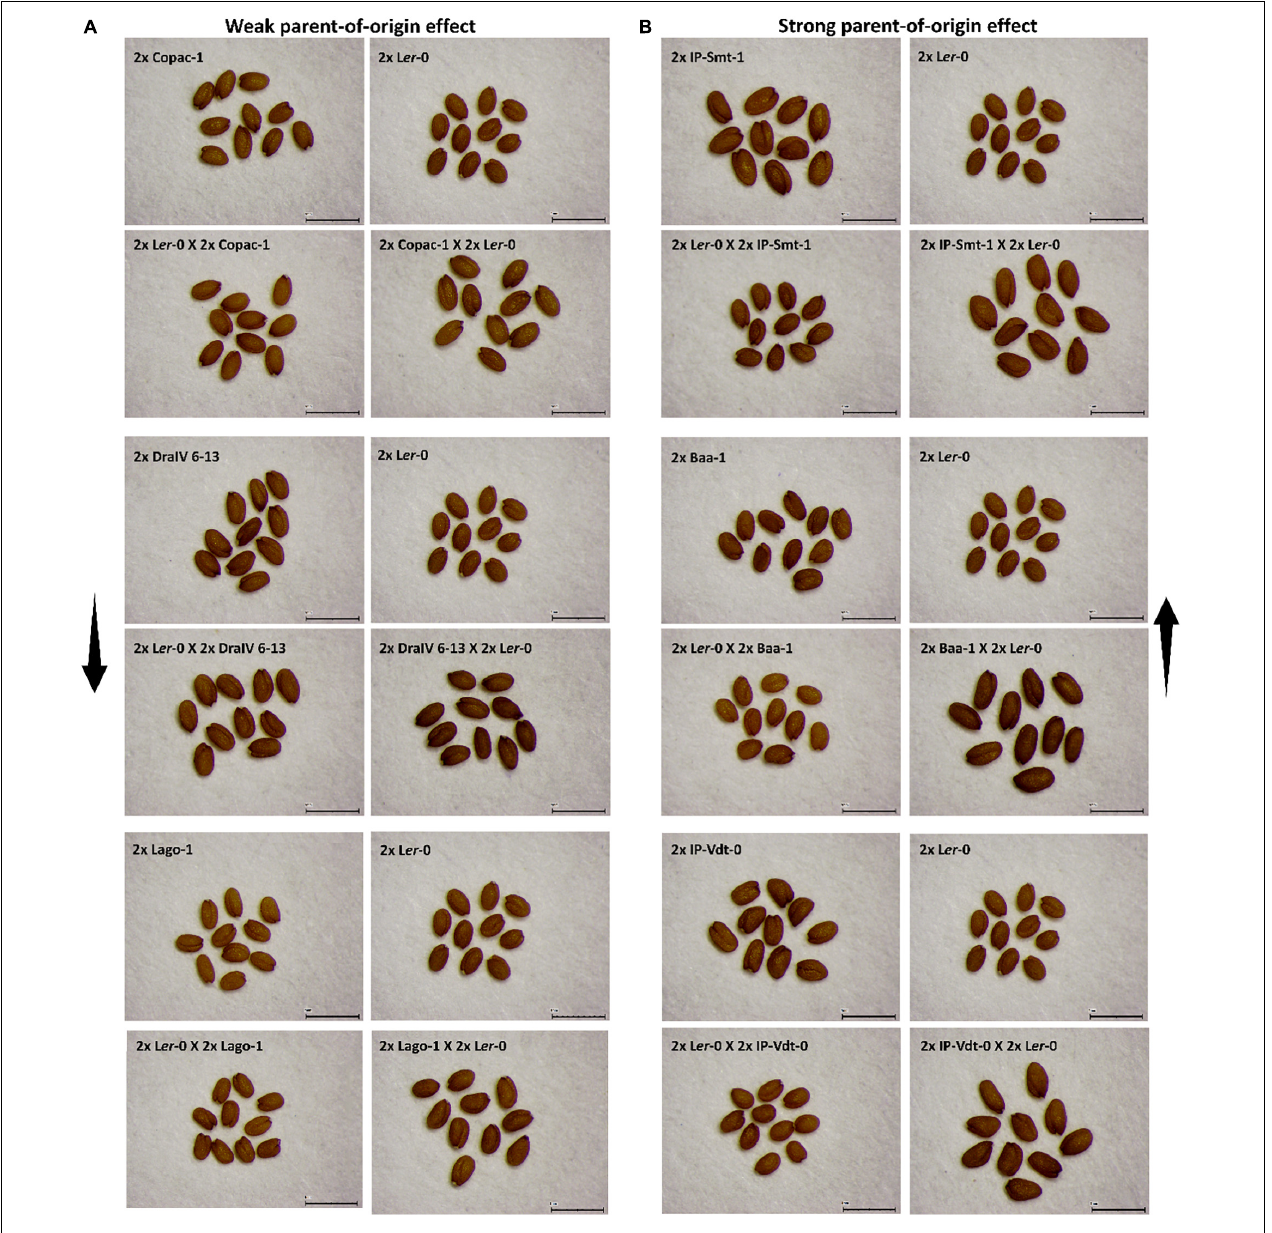
FIGURE 2 | Seed size phenotypes of reciprocal F1 hybrid diploid seeds and their parental lines. (A) The three F1 hybrid diploids with the weakest parent-of-origin effects on F1 seed size in this study and the accessions used as parental lines. The black arrow represents the intensity of parent-of-origin effects in ascending order. (B) The three F1 hybrid diploids with the strongest parent-of-origin effects in this study and their parental lines. The black arrow represents the intensity of parent-of-origin effects, from lowest to highest. Scale bar = 1 mm.